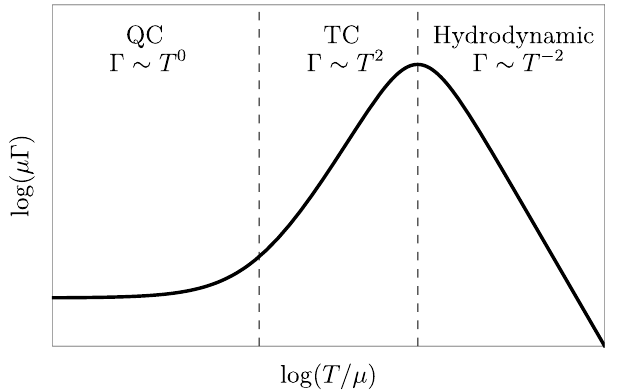
Figure 1. Schematic depiction of the LFL theory form of ln ( (cid:22) (cid:0)), with sound attenuation constant (cid:0), as a function of ln ( T=(cid:22) ) at (cid:12)xed frequency ! and momentum k . The two vertical dashed black p lines represent (cid:25)T=(cid:22) = !=(cid:22) (left) and !=(cid:22) (right). In the quantum collisionless (QC) regime (cid:0) / T 0 , in the thermal collisionless (TC) regime (cid:0) / T 2 , and in the hydrodynamic regime (cid:0) / T (cid:0) 2 . A maximum appears between the thermal collisionless and hydrodynamic regimes, signaling the collisionless-to-hydrodynamic